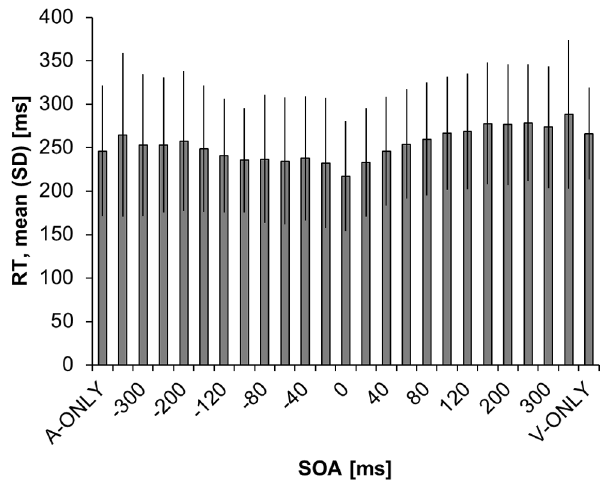
Figure 2. Participants’ performance on the reaction time task at the group level. The group performance on the reaction time (RT) task is plotted as the mean and standard deviation of reaction times as a function of the stimulus onset asynchrony (SOA). A-only and V-only indicate reaction times to unisensory, auditory- and visual-only trials respectively. The complete list of SOAs is provided in the Methods section.